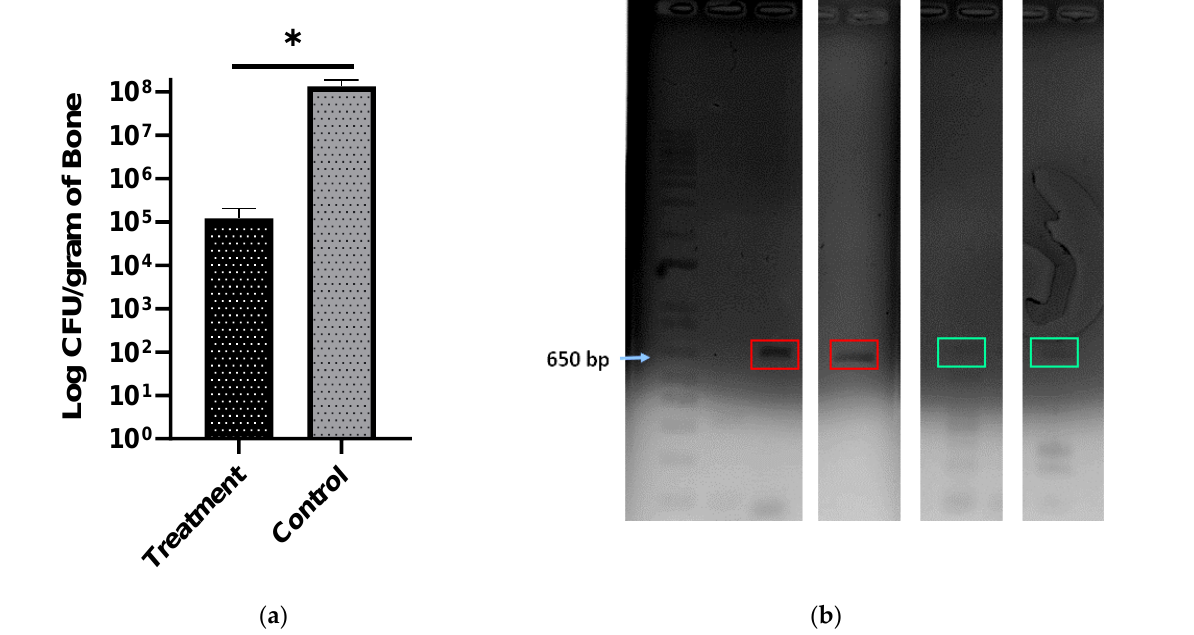
Figure 9. ( a ) Bacterial load per gram of bone in the control and treatment groups. At p < 0.0003, the bacterial load is significantly lower in the treatment group ( n = 6) than in the control group ( n = 4); * p < 0.0003. ( b ) DNA gel images of PCR amplified 16S from S. aureus . The red boxes show DNA bands from control group animals and the bands in the green box are from the treatment group.